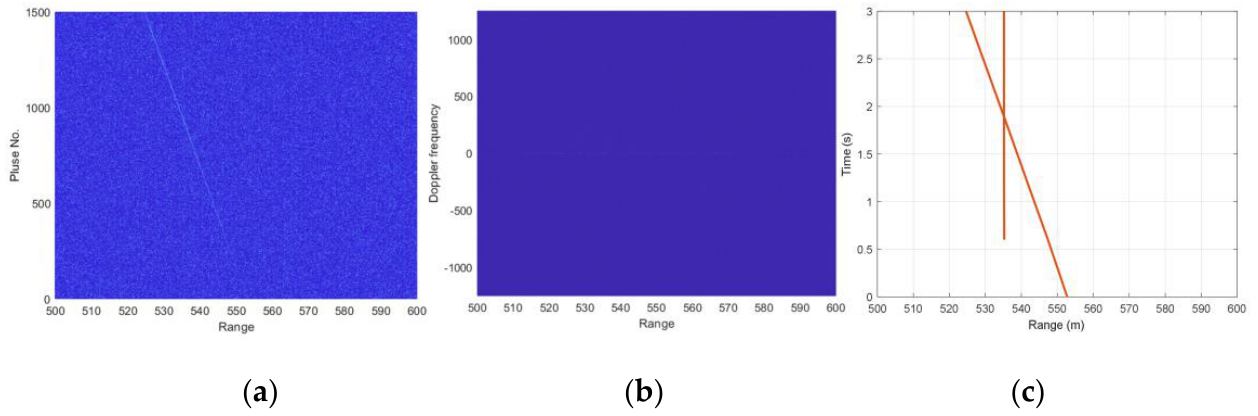
Figure 13. Zoom of the result ( c ) in Figure 10 between 500–600 m; ( a ) PC result; ( b ) MTD result; and ( c ) BMMO